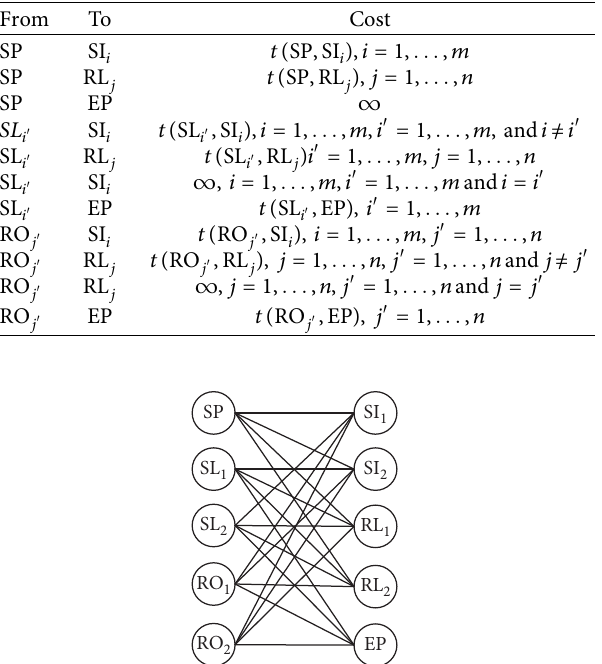
Table 1: Costs related to edges in the sequencing problem. From To